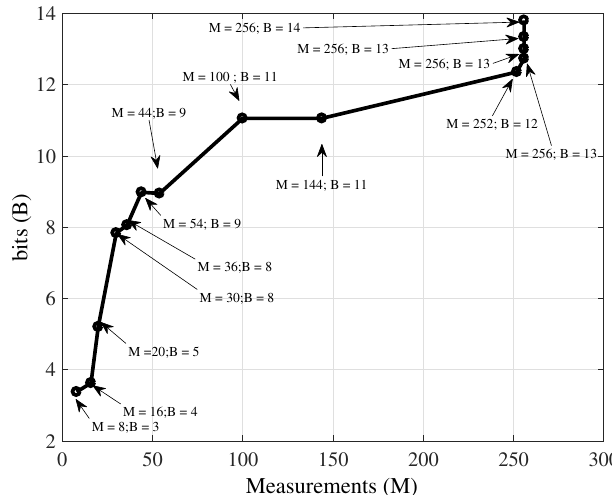
Figure 7. Optimal coding path on the M × B plane, the points that correspond to the RD convex hull, for the reconstruction of a temperature signal with